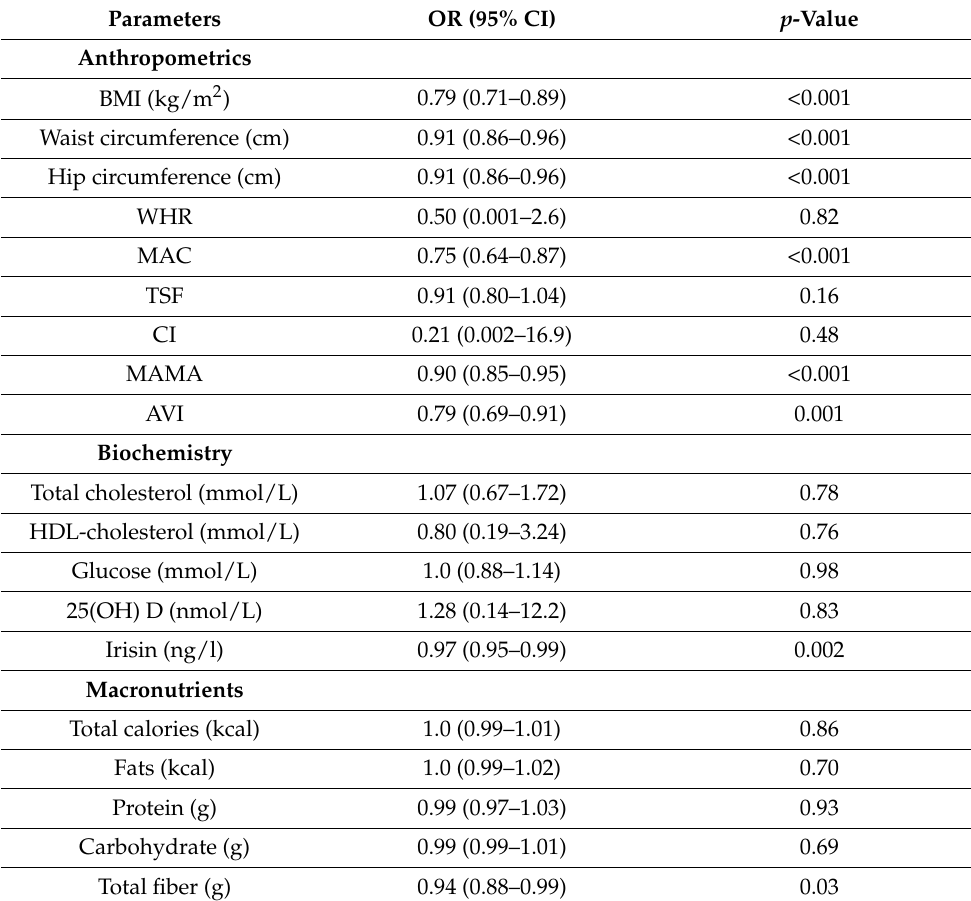
Table 3. Associations of select parameters with sarcopenia.